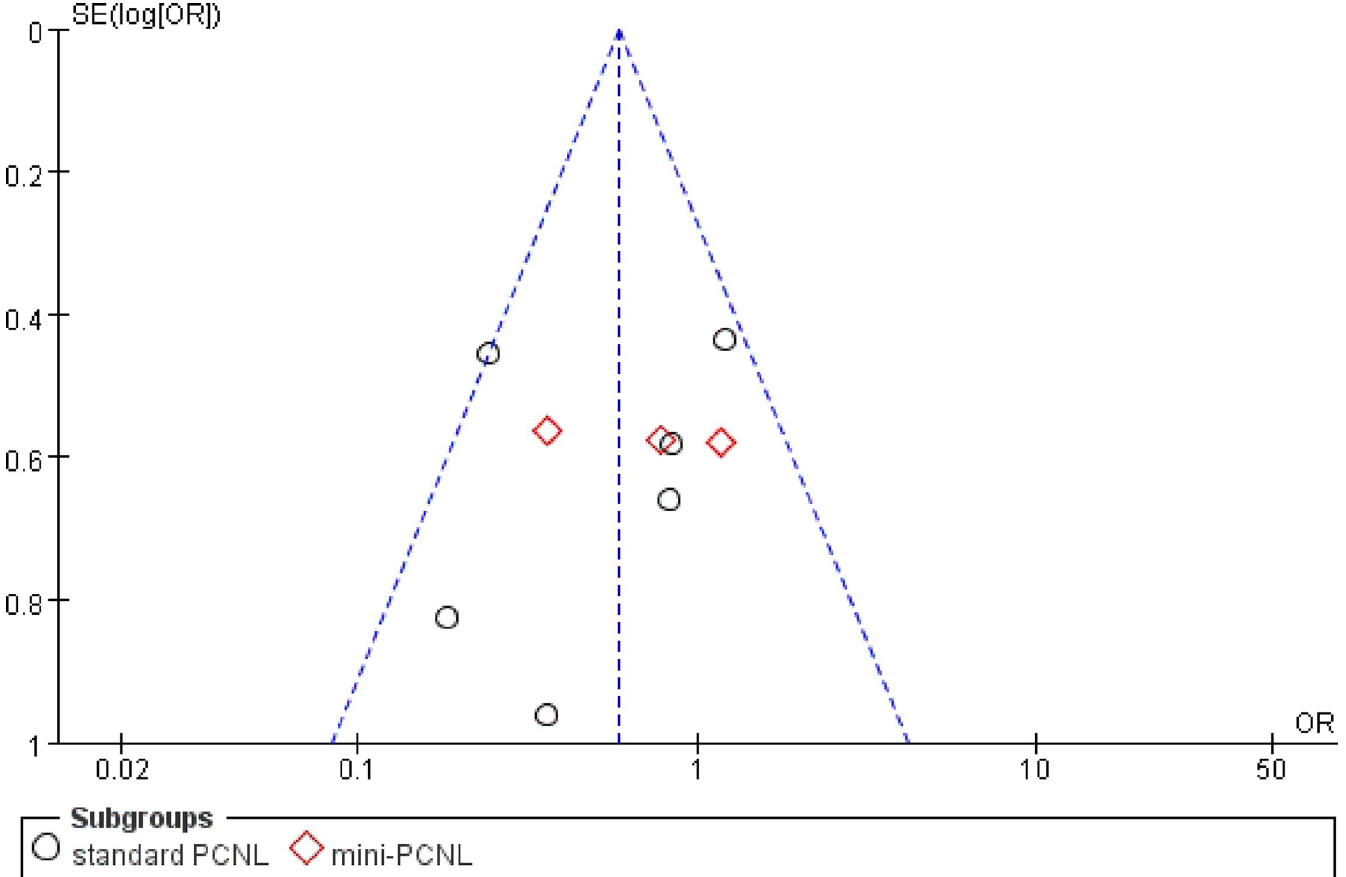
Fig 6. Funnel plot for assessing publication bias (overall